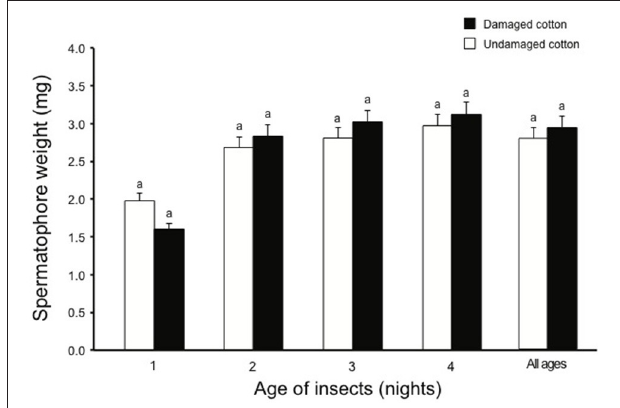
FIGURE 6 | Mean spermatophore weight in S. littoralis moths when allowed to mate in the presence of damaged (black bars) and undamaged (white bars) cotton plants, separately. Standard errors are represented on each bar. Chi square test was used for statistical analysis. Different letters within bars of each age show significant effect ( P < 0.05, or 0.01or 0.001).